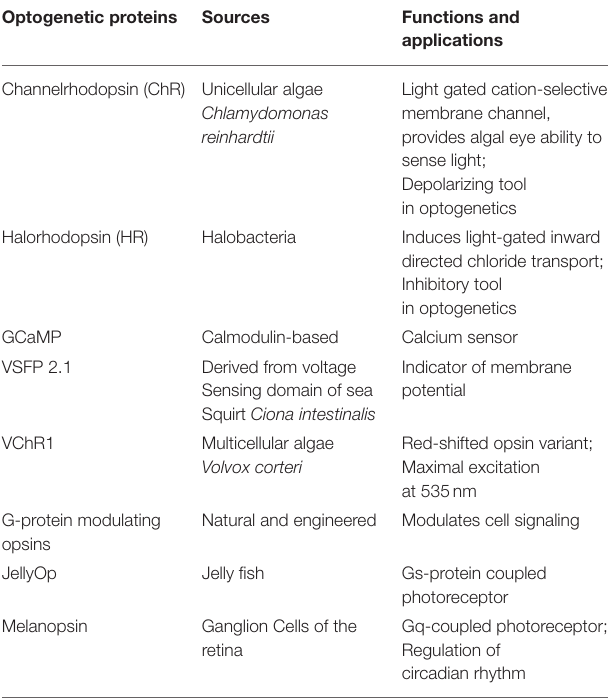
TABLE 1 | A list of optogenetic proteins in cardiovascular research and